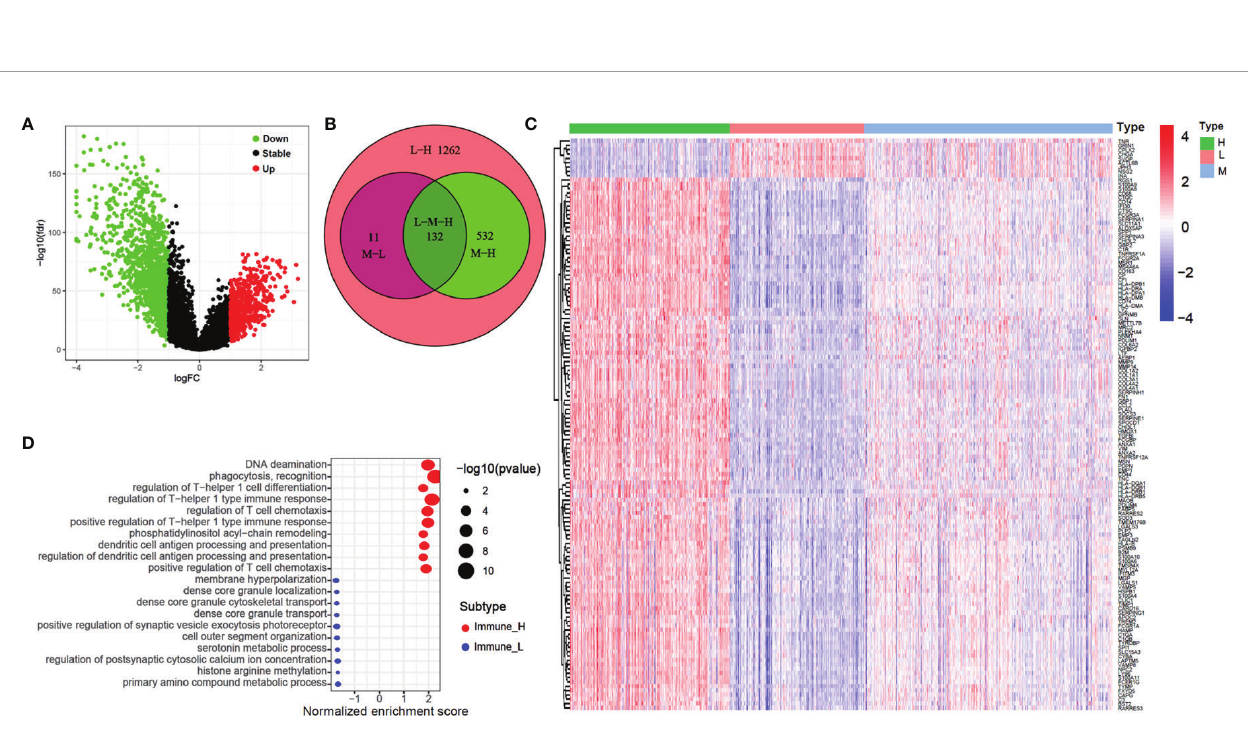
FIGURE 5 | Volcano plot, heatmap and GO enrichment analysis of differential gene among three glioma immune subtype. (A) The volcano plot of different genes between immunity-H and immunity-L subtype. (B) The Venn plot showed the different genes among three glioma immune subtype. (C) The heatmap shown that the different genes among three glioma immune subtype. (D) GO enrichment analysis of differential gene among between immunity-H and immunity-L